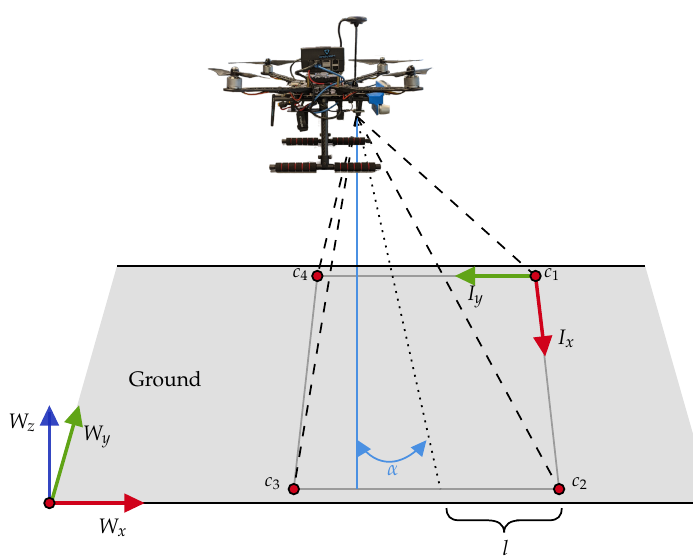
Figure 6. Two-dimensional (2D) projection of vision-based sensors pointing to the ground, where W is the world coordinate frame, I is the image coordinate frame, α is the camera’s gimbal angle from the vertical, c ∗ are the rectangular corners from the camera’s Field of View (FOV), and l is the footprint extent of the